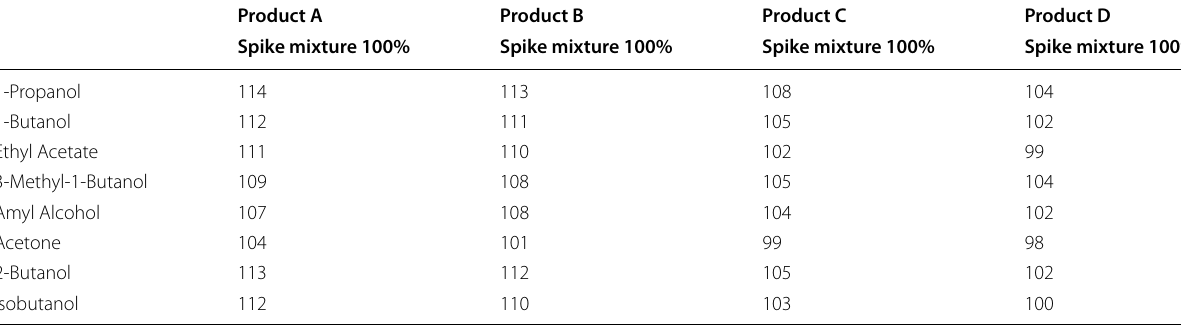
Table 6 Validation of spike recovery assay for level 2 impurities using concentration at 100% of the temporary guidance limits